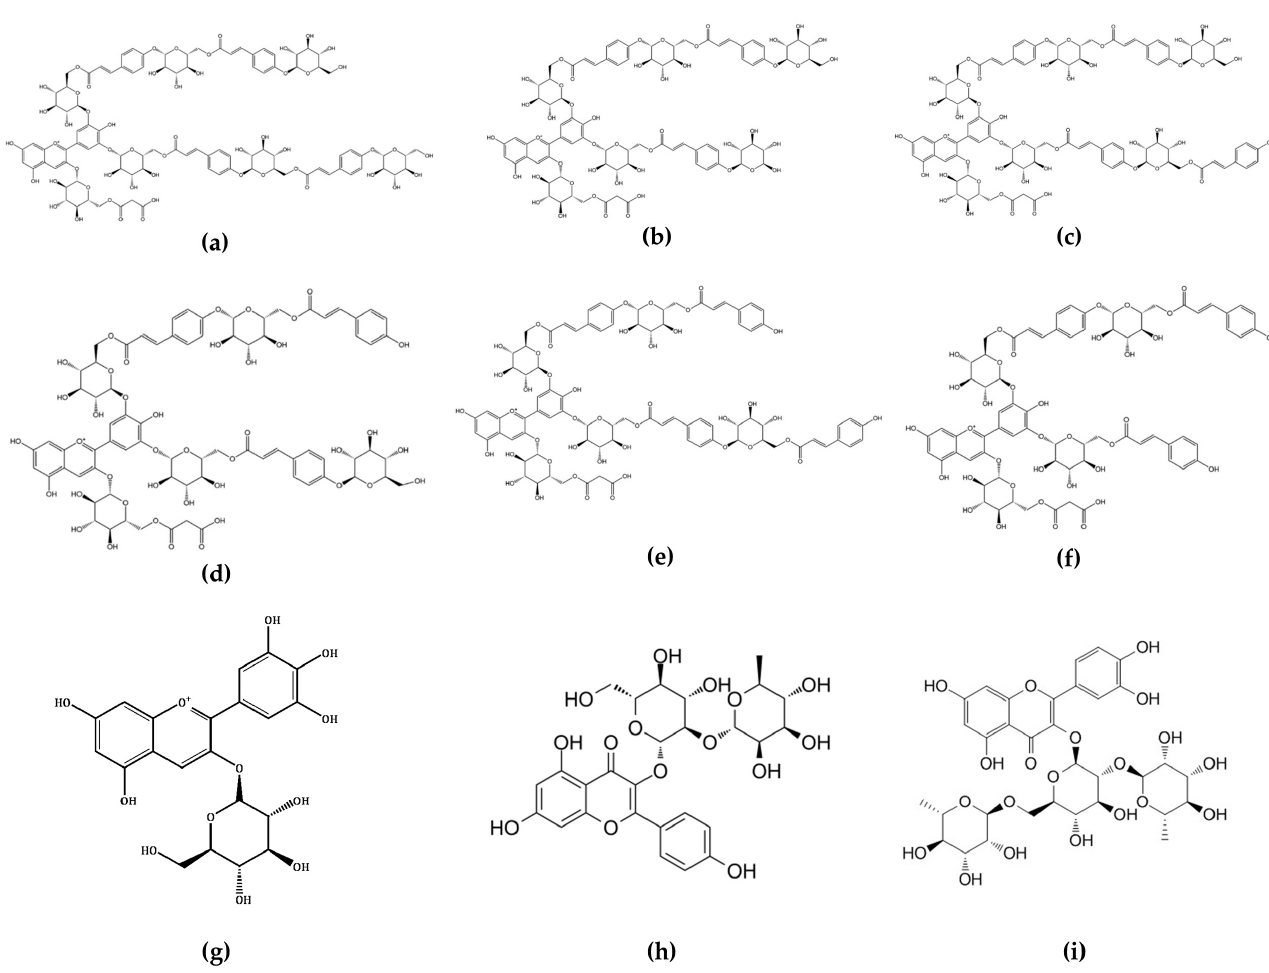
Figure 2. Anthocyanins in C. ternatea flowers: ( a ) Ternatin A1; ( b ) Ternatin A2; ( c ) Ternatin B1; ( d ) Ternatin B2; ( e ) Ternatin D1; ( f ) Ternatin D2; ( g ) Delphinidin 3-O-glucoside; ( h ) Kaempferol 3-neohesperidoside; ( i ) Quercetin 3-O-rutinoside.